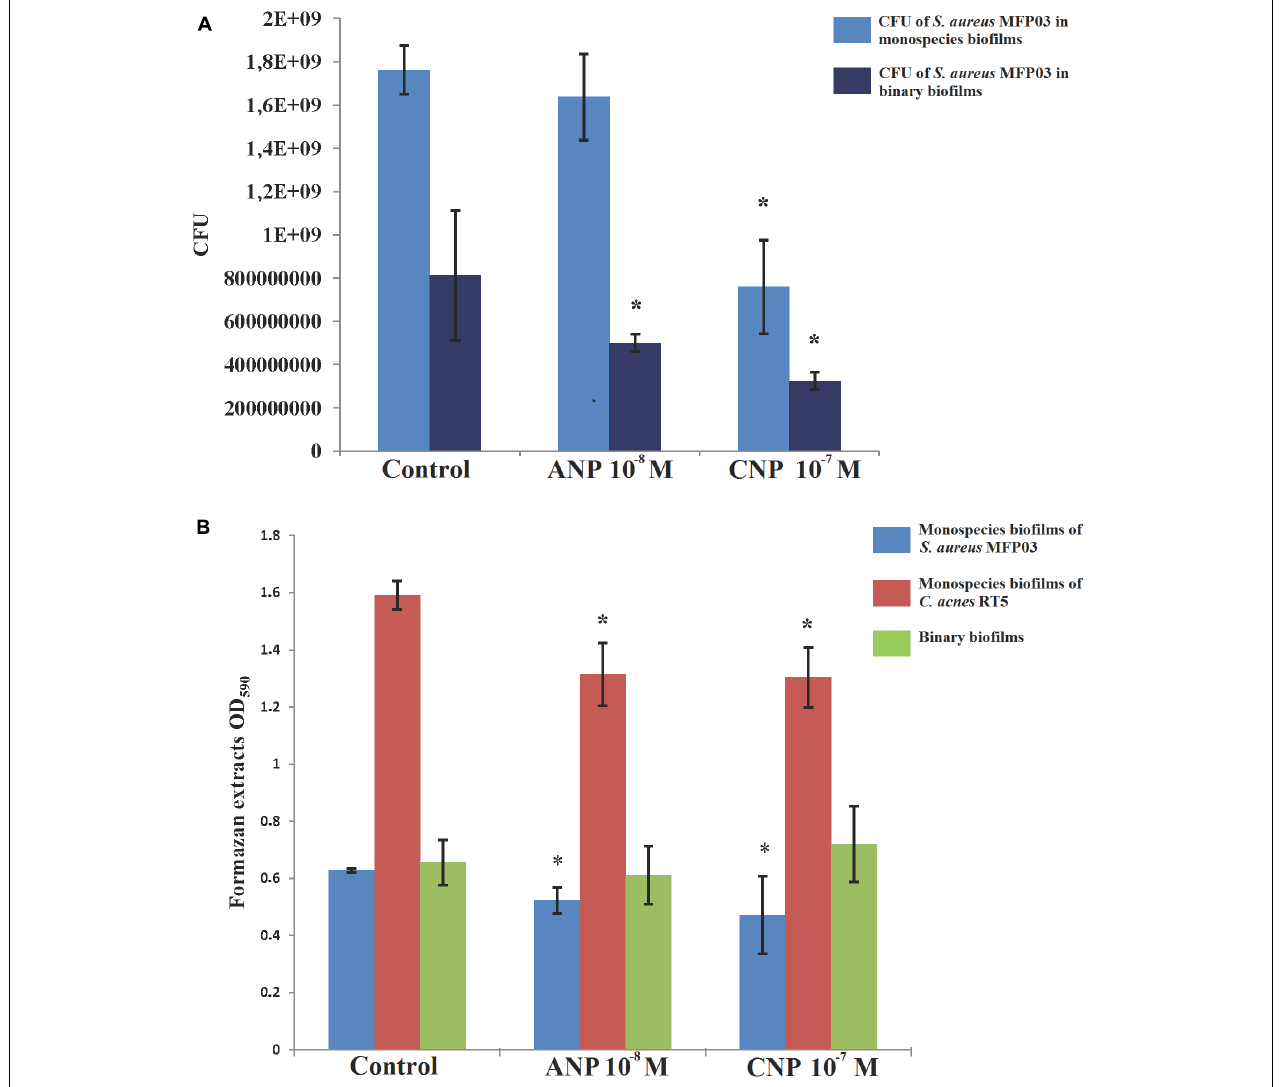
FIGURE 6 | Effects of ANP and CNP on mixed biofilms of S. aureus MFP03 and C. acnes RT5 at 33 ◦ C. (A) S. aureus MFP03 CFU and (B) MTT biofilm values. ∗ P < 0.05.